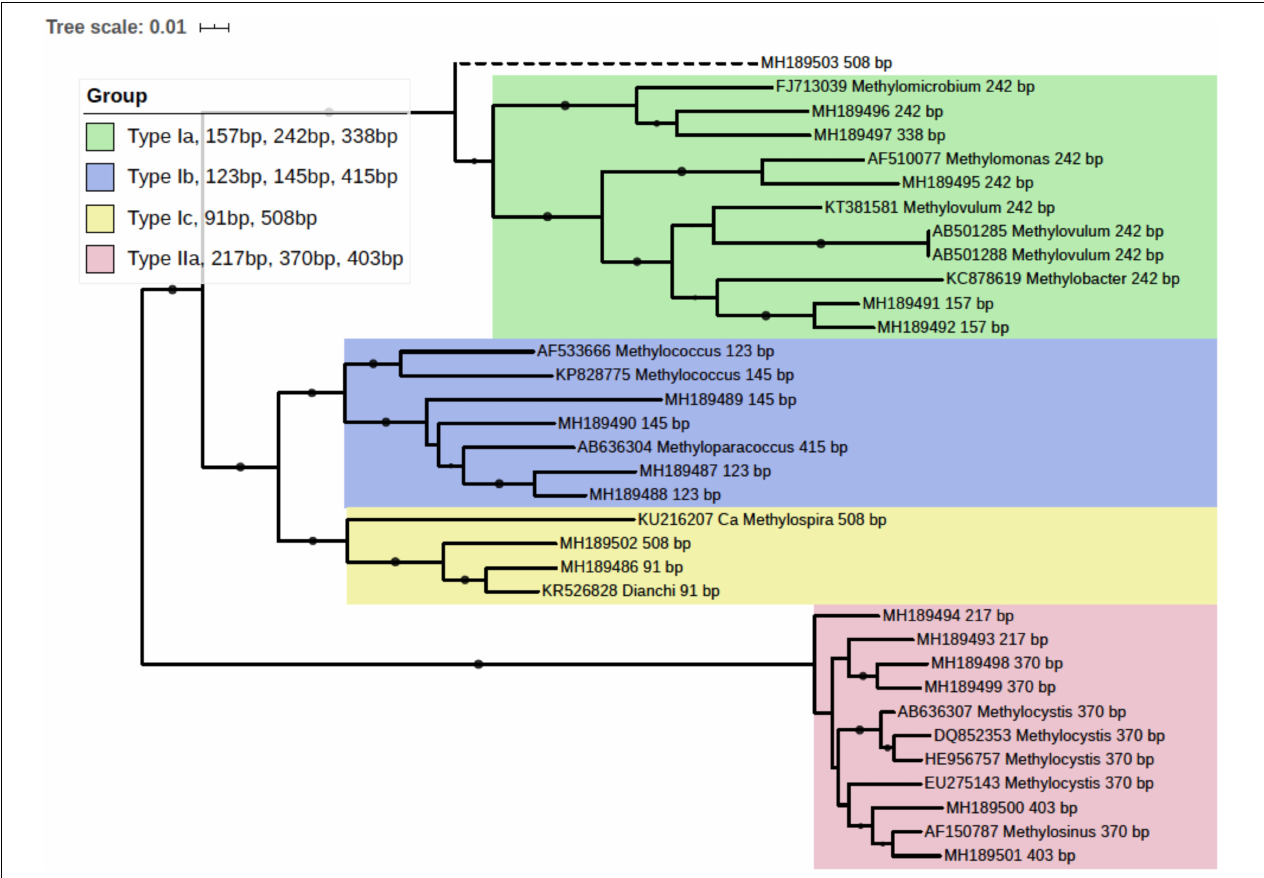
FIGURE 3 | Phylogenetic tree of obtained pmoA sequences and reference sequences from the GenBank database. The predicted cut sites were shown after the accession numbers of sequences. The dots at branches represent the support values from bootstrap test. Branch support values of no less than 50 were dotted. The bar represents 1% sequence divergence based on neighbor-joining